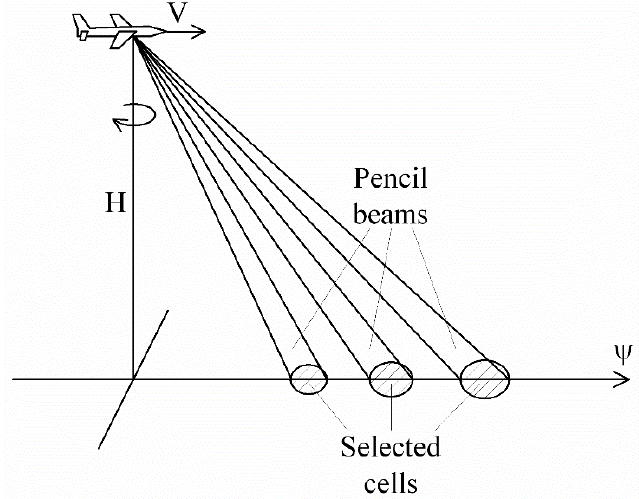
Figure 1. Rotating antenna multibeam geometry (three-beam case in the vertical plane): V is the speed of flight; H is the altitude; ψ is the aircraft flight direction.